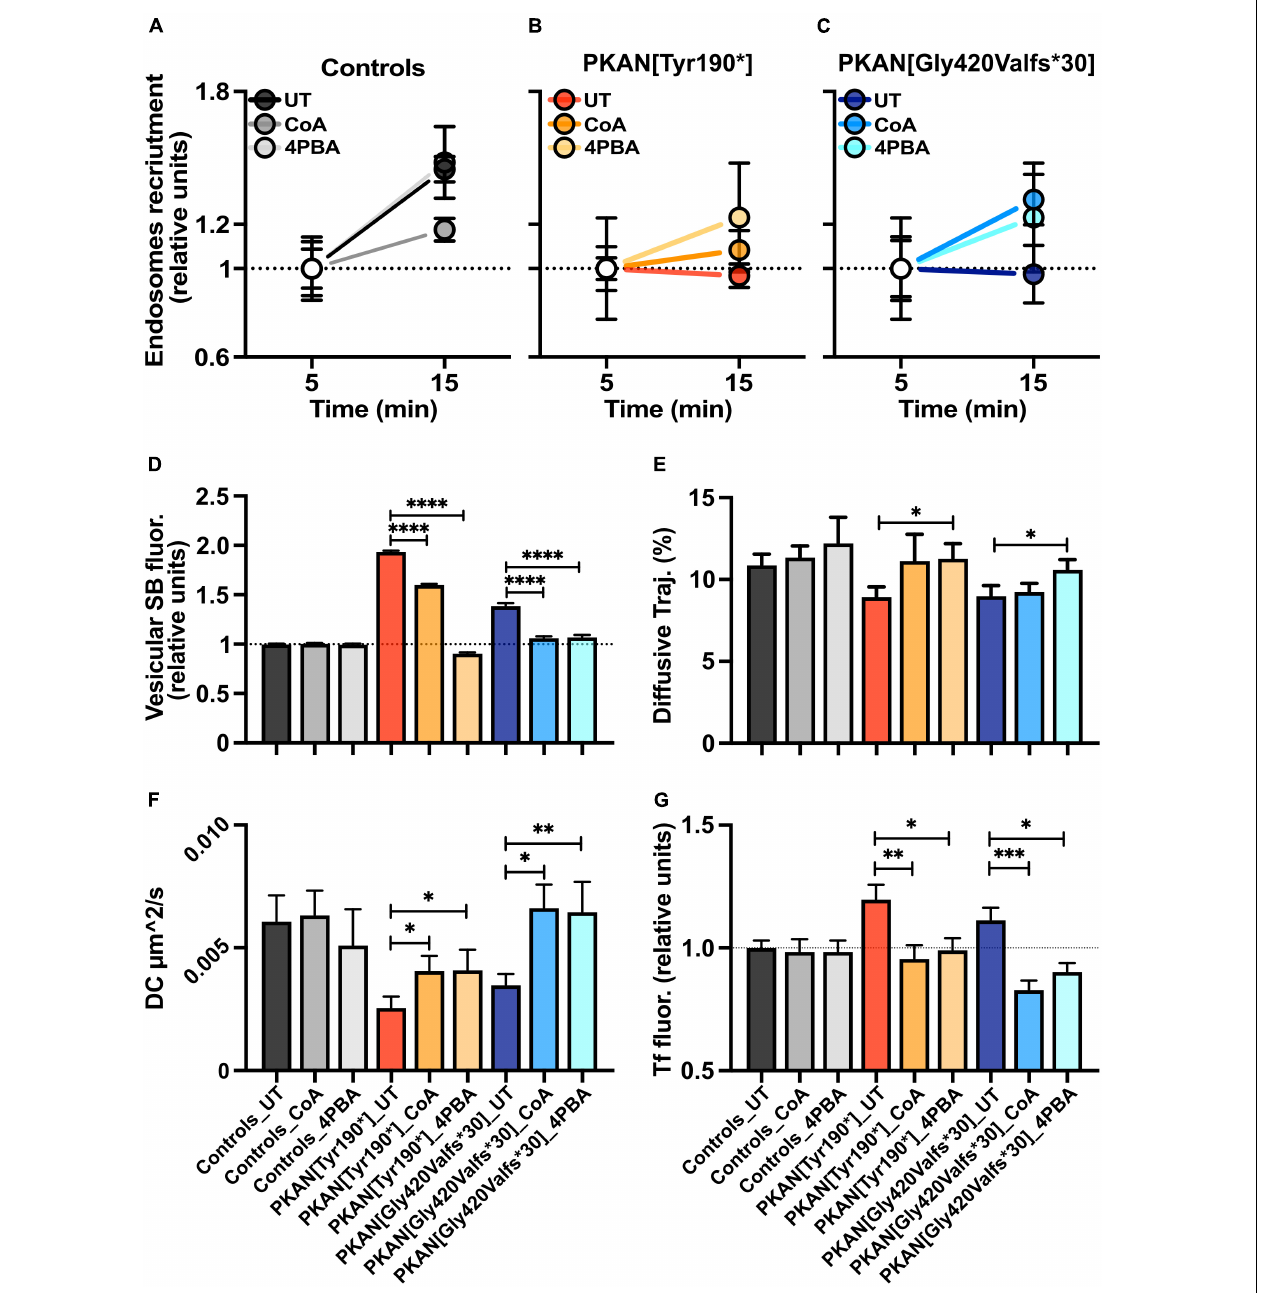
FIGURE 4 | Effect of CoA and 4-PBA treatments on constitutive endosomal trafficking. (A–C) Plots are the percentages of active endosomes, identified as described in methods and results, at different time points (5 min and 15 min). (D) Bars show the mean vesicular Synbond uptake (15 min pulse) in astrocytes from controls and PKAN, treated with CoA or 4-PBA ( t -test, n ≥ 5,706 vesicles analyzed for each, from n ≥ 3 independent replicates). (E) Mean % of diffusive trajectories in different conditions. (F) Mean Diffusion Coefficient in astrocytes from control and PKAN in different conditions, calculated from dynamics of live-tracked endosomes enriched in Synbond [ (E,F) Mann–Whitney, n ≥ 20 cells analyzed for each, from at least three independent replicates]. (G) Plots are the Tf uptake (15 min) in controls and PKAN astrocytes treated with CoA or 4-PBA. In all cases, cells were treated with 25 µ m CoA and 0.5 µ m 4-PBA (Mann–Whitney, n ≥ 27 cells analyzed for each, from at least three independent replicates). Error bars are SEM for all. ∗ p < 0.05; ∗∗ p < 0.01; ∗∗∗ p < 0.001; ∗∗∗∗ p < 0.0001 for